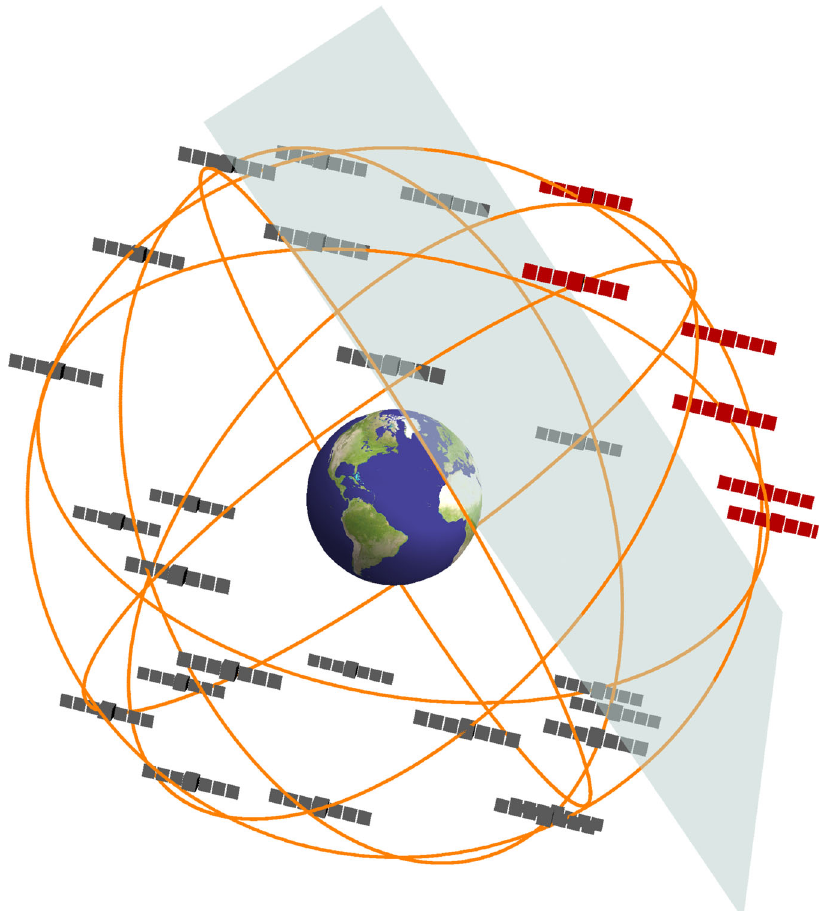
Fig. 1 Domain wall crossing. As a domain wall sweeps through the Global Positioning System constellation at galactic velocities, v g ~ 300 km s − 1 , it perturbs the atomic clocks on board the satellites causing a correlated propagation of glitches through the network. The red satellites have interacted with the domain wall, and exhibit a timing bias compared with the grey satellites. Image generated using Mathematica software 48